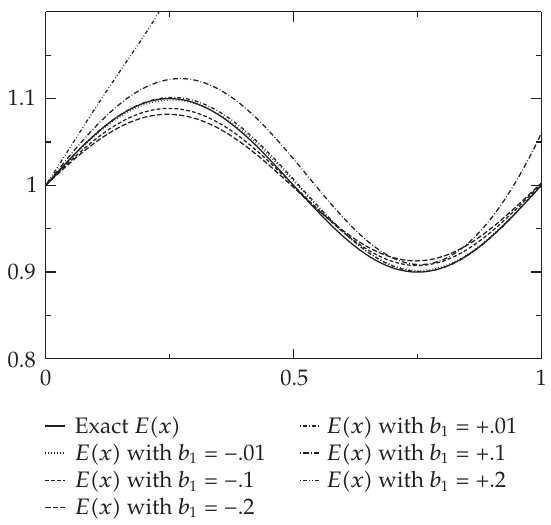
Figure 8.2 . The reconstructed elastic modulus E ( x ) = 1 + . 1sin ( 2 πx ) for various b 1 values using n = 128 grid